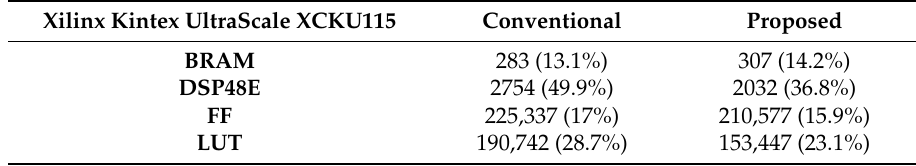
Table 4. OMP hardware utilization comparison between conventional partitioned inversion and proposed partitioned inversion. BRAM—block ram;